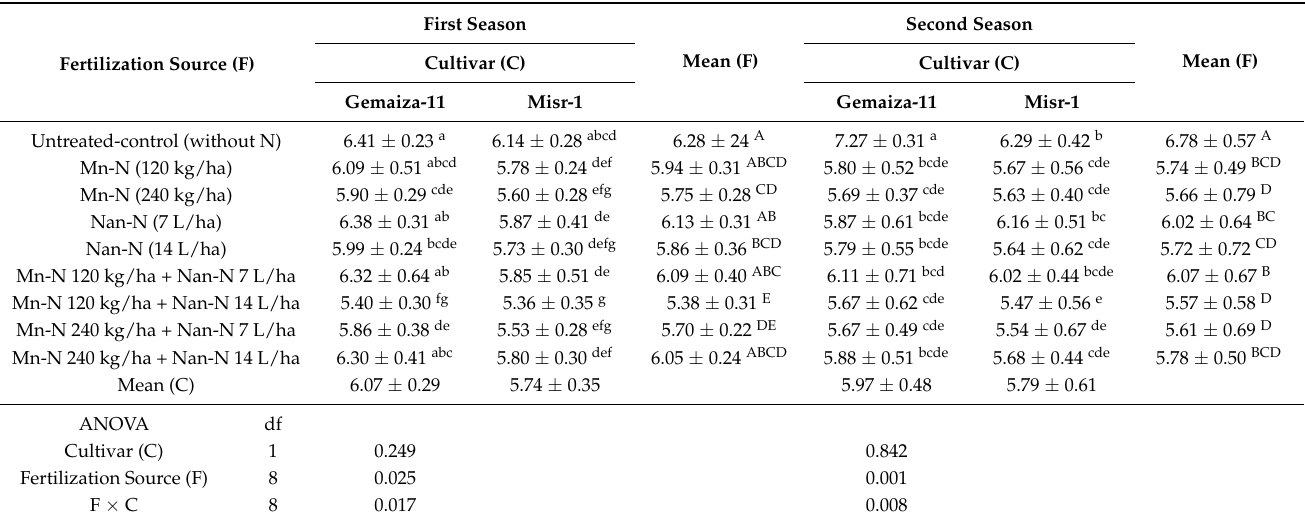
Table 12. Impact of nano- and mineral nitrogen fertilizers on the sodium concentrations (Conc; mg/L) of two wheat cultivars during the 2019/2020 and 2020/2021